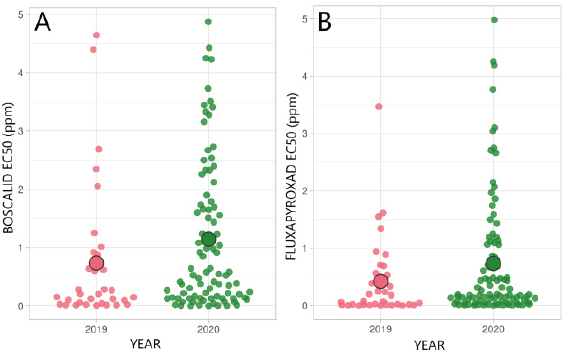
Figure 4. Sensitivity of R. collo-cygni in 2019 and 2020 in Estonia to SDHI fungicides boscalid ( A ) and fluxapyroxad ( B